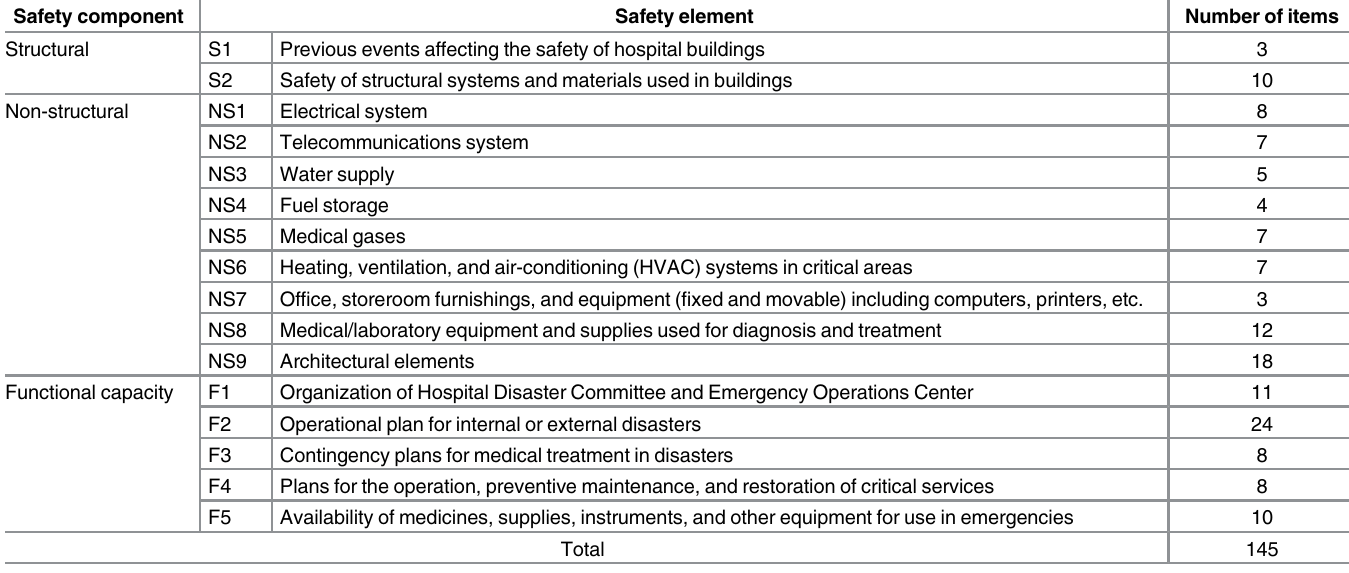
Table 1. Components of hospital safety in Farsi Hospital Safety